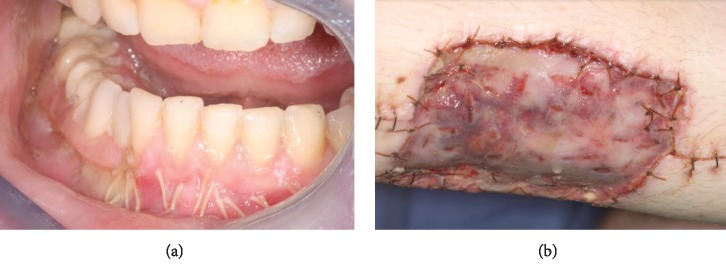
One-week postoperative photos. (a) Intraoral photo showing provisional prosthesis in place. (b) Photo showing lower extremity donor site with skin graft in place. No issues with postop bleeding.